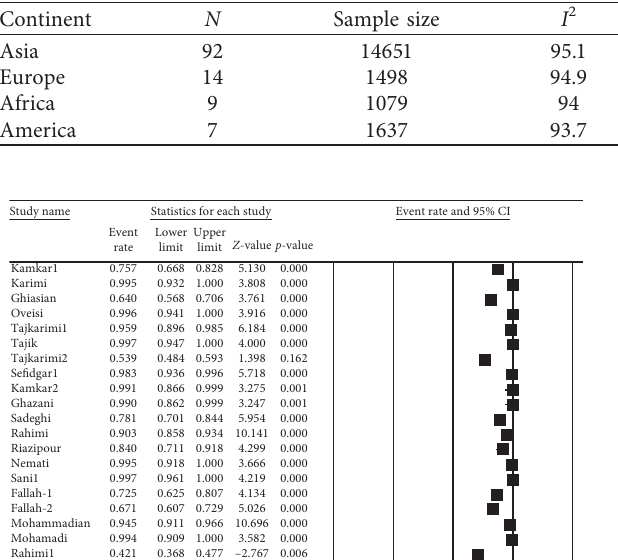
Table 2: Analysis of subgroups by continents.